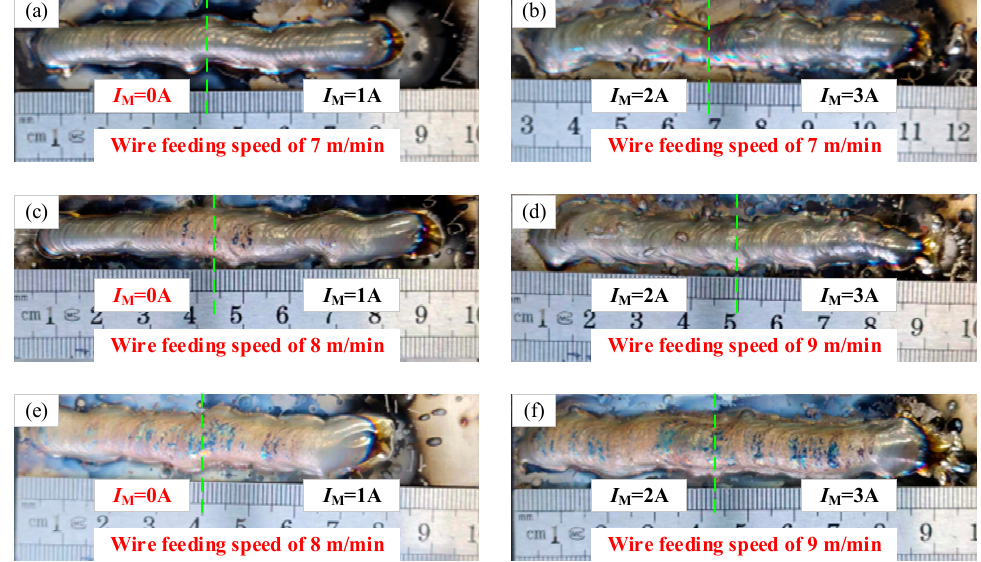
Figure 2. Surface morphology of the titanium alloy single deposition layer: ( a , b ) shows the wire feeding speed of 7 m/min, ( c , d ) shows the wire feeding speed of 8 m/min, ( e , f ) shows the wire feeding speed of 9 m/min.